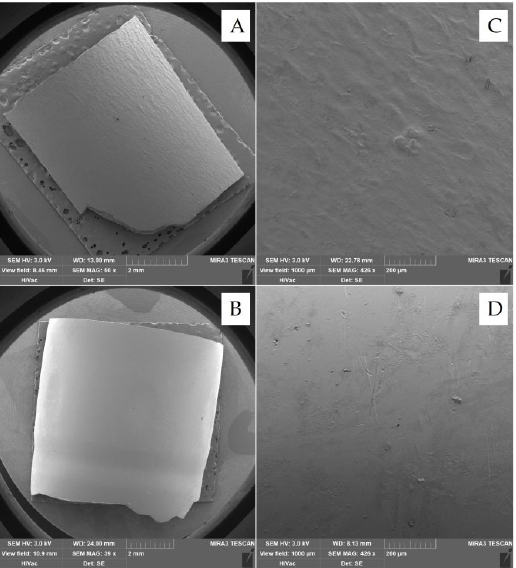
Figure 4. SEM images of the structure of the surface of capsules; ( A ) hard gelatin capsule; ( B ) DRcaps TM capsule; ( C ) hard gelatin capsule (1000 μ m view field); ( D ) DRcaps TM capsule (1000 μ m view field).